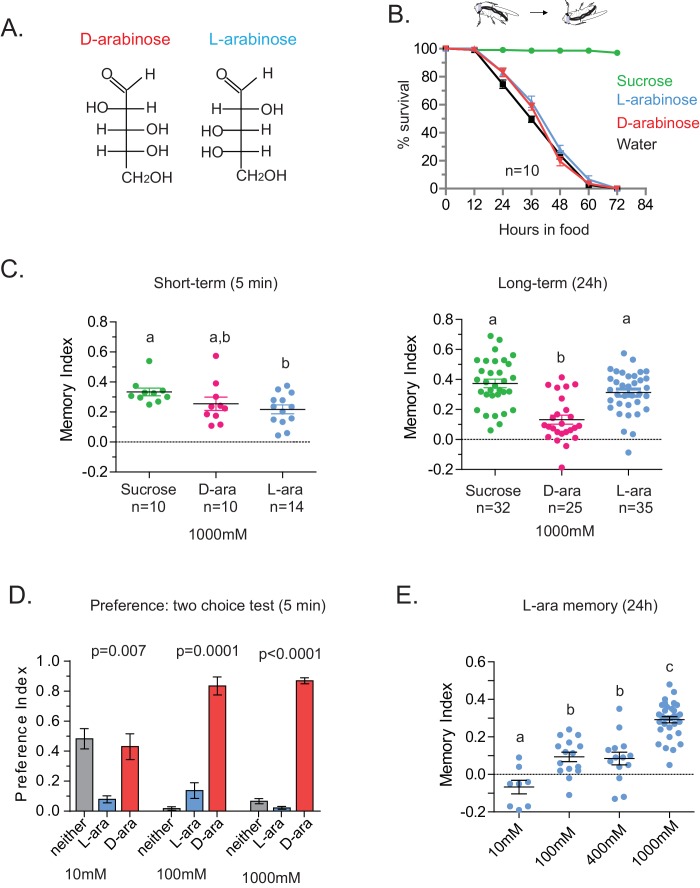
Flies’ immediate preference for a sugar is not predictive of their long-term memory: L- vs D-arabinose.(A) Structures of D- and L-arabinose. (B) Survival percentages for flies given solely 1 M sugar solutions. n = 10 (50 flies per n) for each time point. (C) Short- and long-term memory of sucrose and D- and L-arabinose. (D) Two-choice tests comparing flies’ preference for D- and L-arabinose when both sugars are presented side-by-side for 5 mins. n = 4 (50 flies per n). (E) Long-term (24 hr) memory scores for increasing concentrations of L-arabinose. Results with error bars are means ± s.e.m. ns, not significant. *≤0.01, **≤0.001 and ***≤0.0001. The significant differences (p<0.05) between conditions in Figure 2C and E were analyzed by one-way ANOVA with Tukey’s multiple comparisons test and differences are denoted by different letters. Detailed explanations of what constitutes a single n is found in Materials and methods.